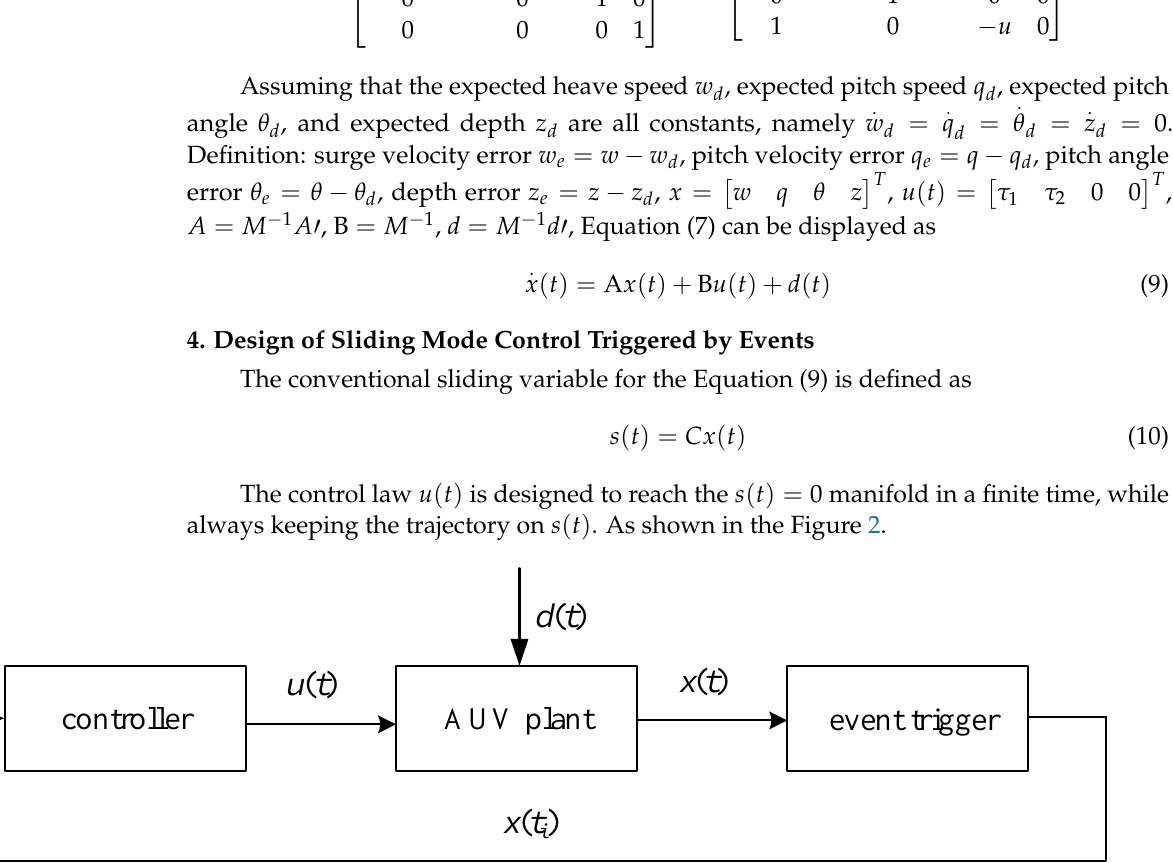
Figure 2. Event-triggered control loop.